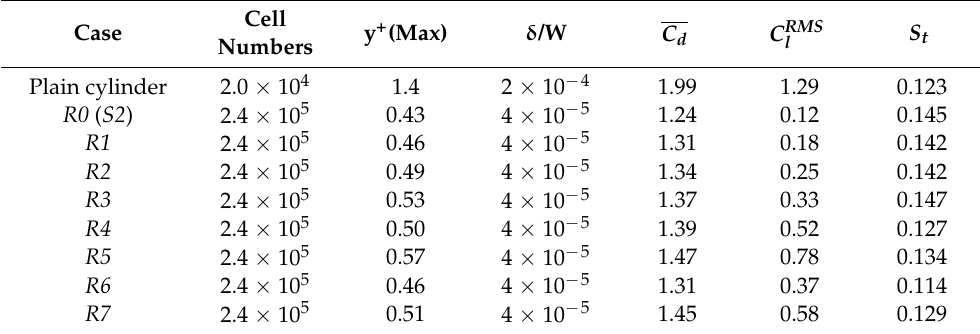
Table 6. Force coefficient for the nine rotating cases and plain